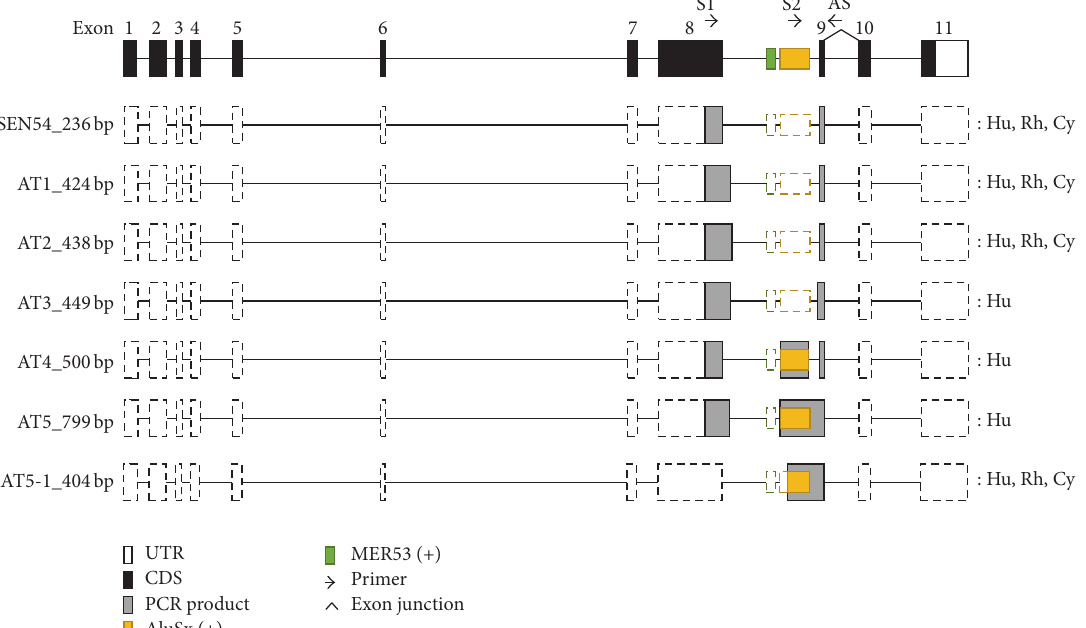
Figure 3: Structure of TSEN54 original and alternative transcripts. Open, closed black, and gray boxes represent the untranslated region of exons, protein coding region, and PCR product, respectively. Dashed boxes indicate the predicted TSEN54 gene structure. Arrows indicate primer